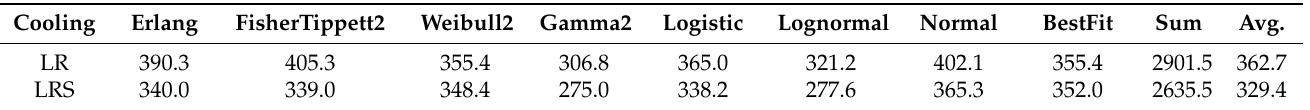
Table 4. Results of the mean absolute errors of cooling energy use probability density functions stemming from each input weather variable distribution series for LR and LRS regression models.